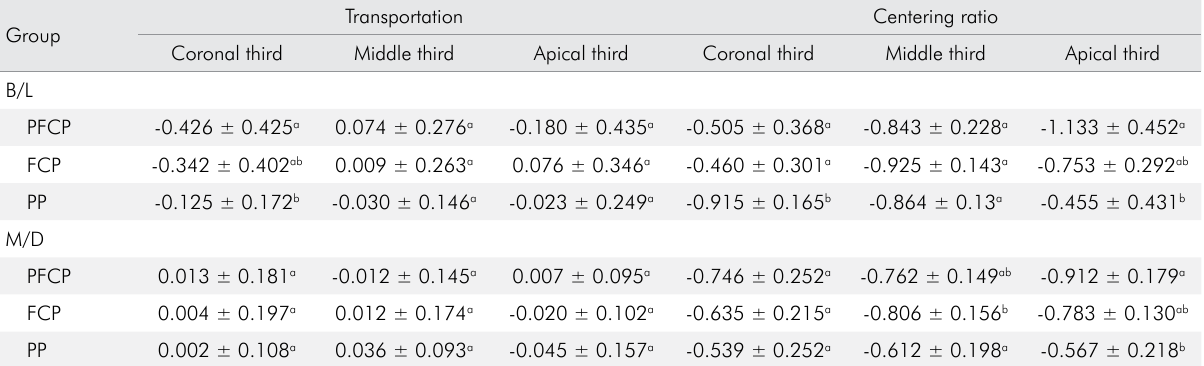
Table 3. Canal transportation after different instrumentation protocols. A result of ‘0’ indicates no canal transportation. A result of 1 indicates perfect centering ability (Mean ±